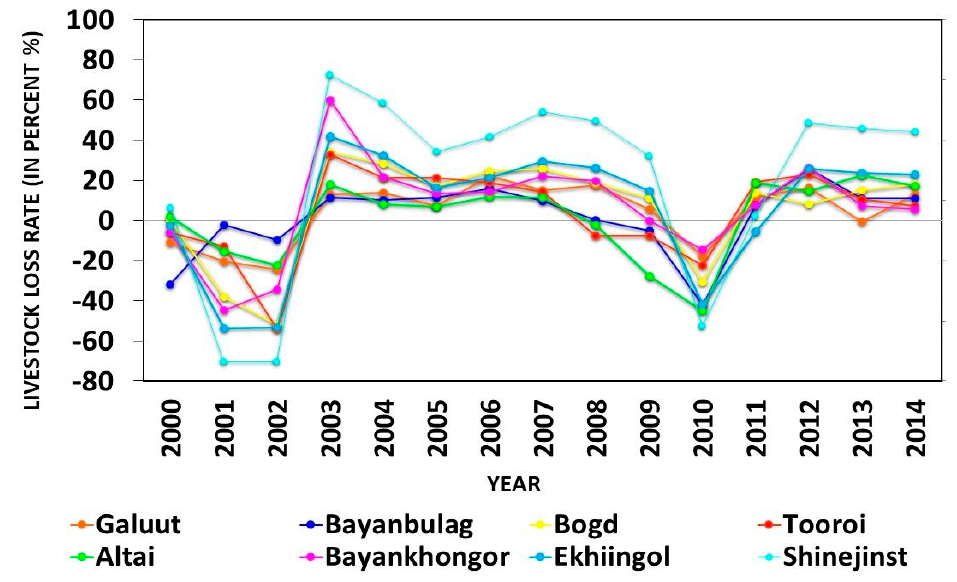
Figure 10. Livestock loss rate in percent from 2000 to 2014 (where negative values equal losses). Data: National Statistical Office of Mongolia.